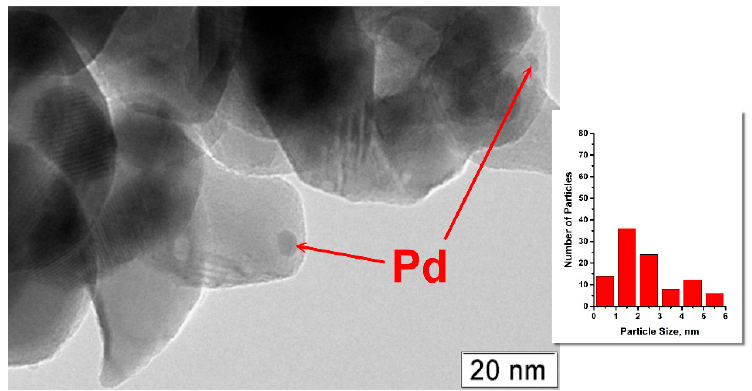
Figure 13. TEM image of 0.8% Pd/ZrO 2 sample after sulphation and calcination at 500 °C.